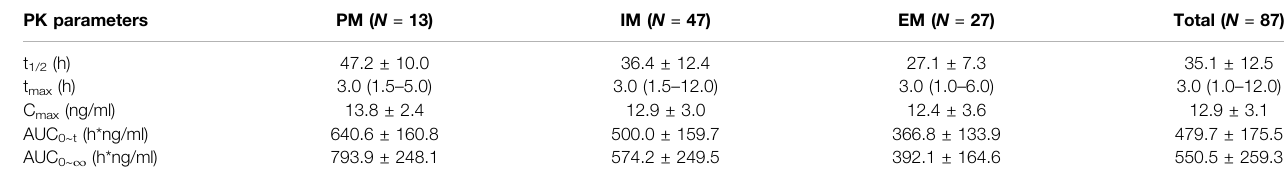
TABLE 2 | Summary statistics for the main pharmacokinetic parameters of different type of metabolizers of escitalopram. PK parameters